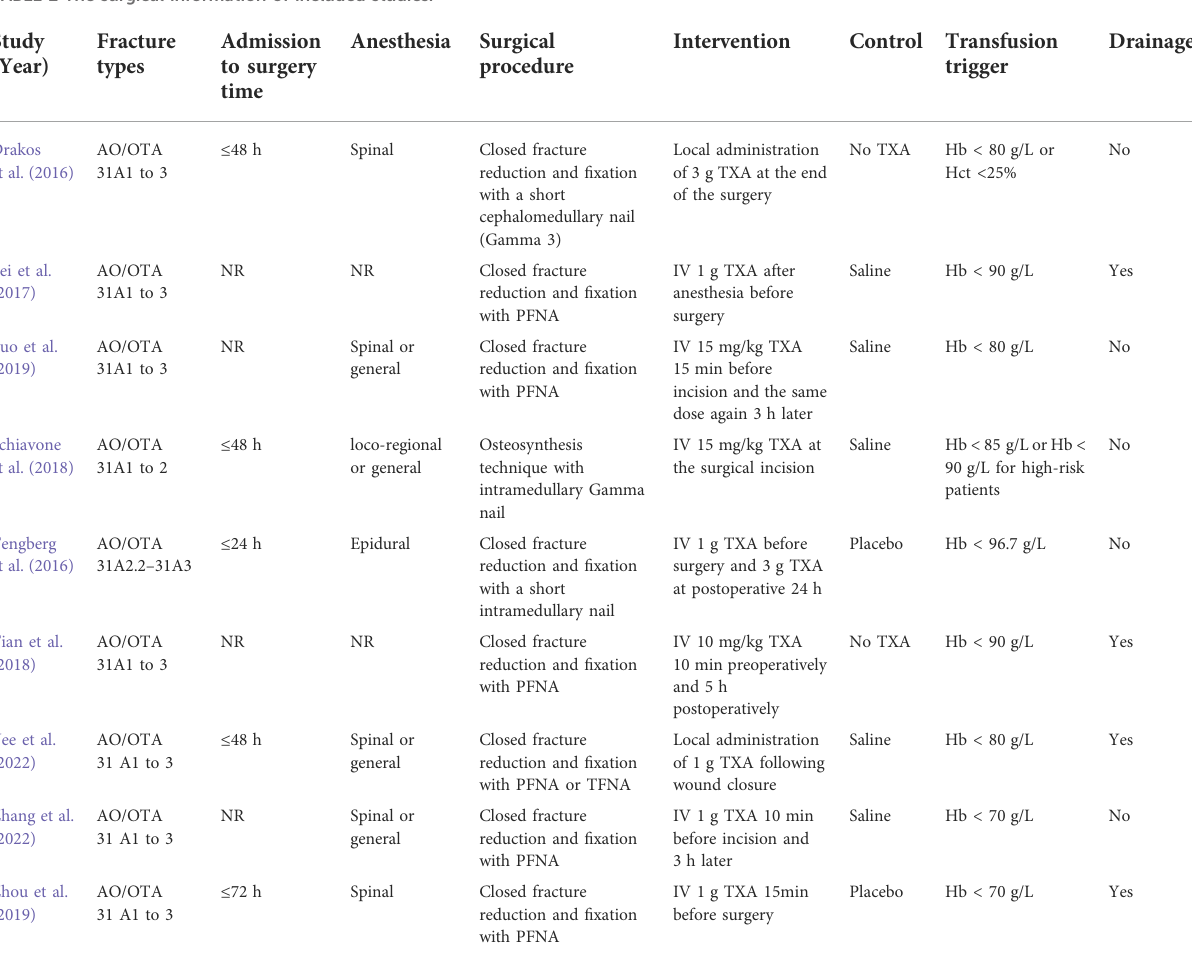
TABLE 2 The surgical information of included